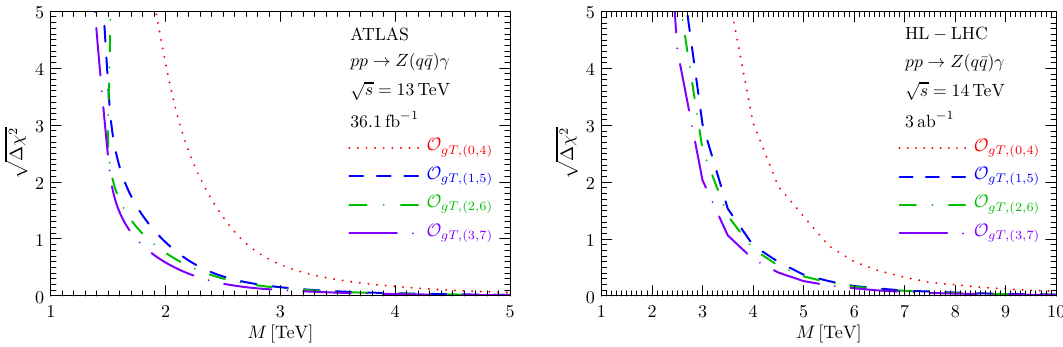
p Figure 8 . The significances ∆ χ 2 for probes of the individual dimension-8 gQGC operators O , where i = 0 , 1 , 2 , 3 , from the Z ( q ¯ q ) γ channel as functions of the cut-off scales M i . The gT, ( i,i +4) left panel shows the sensitivities obtained using the current LHC data with luminosity L = 36 . 1 fb − 1 while the right panel shows the estimated sensitivities for the future √ HL-LHC with s = 14 TeV and L = 3 ab − 1 .